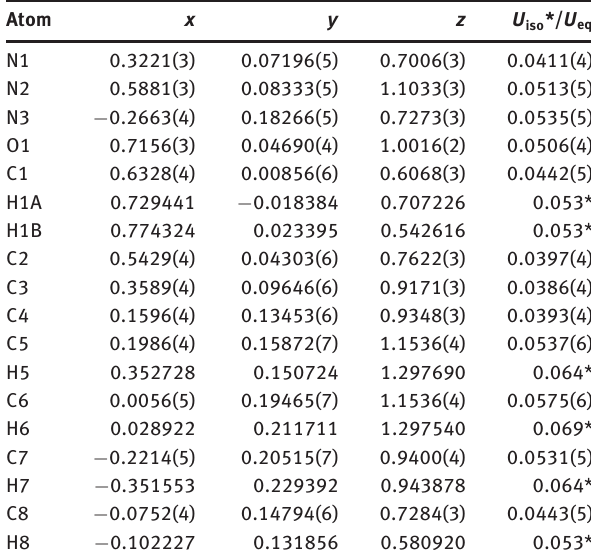
Table 2: Fractional atomic coordinates and isotropic or equivalent isotropic displacement parameters (Å 2